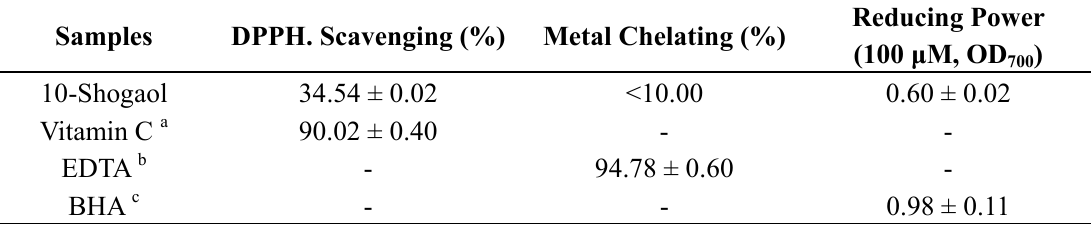
Table 1. Antioxidant effects of